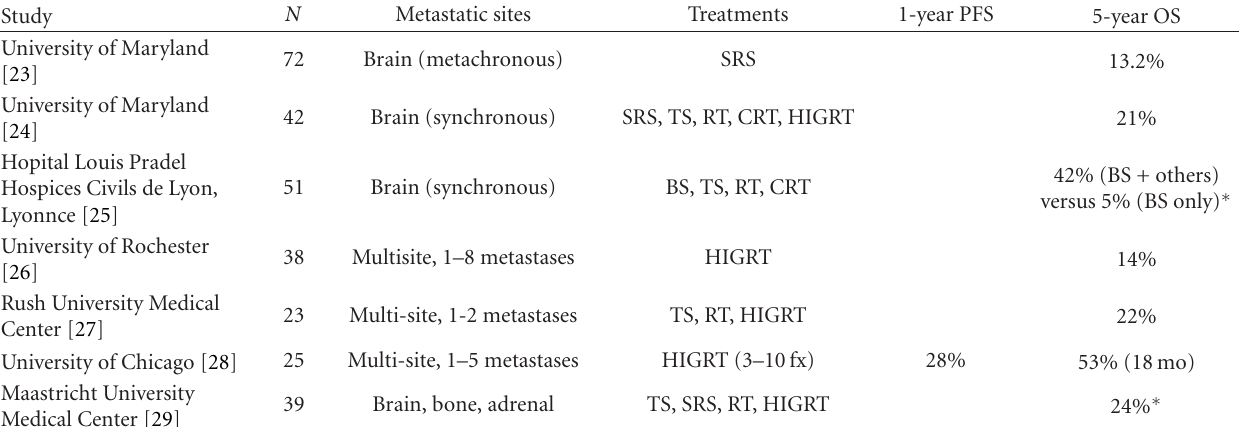
Table 1: Selected series for the comprehensive treatment of metastatic NSCLC.